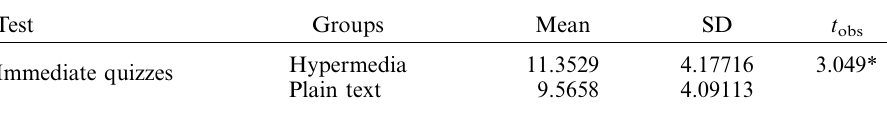
Table 3. Immediate quizzes results.